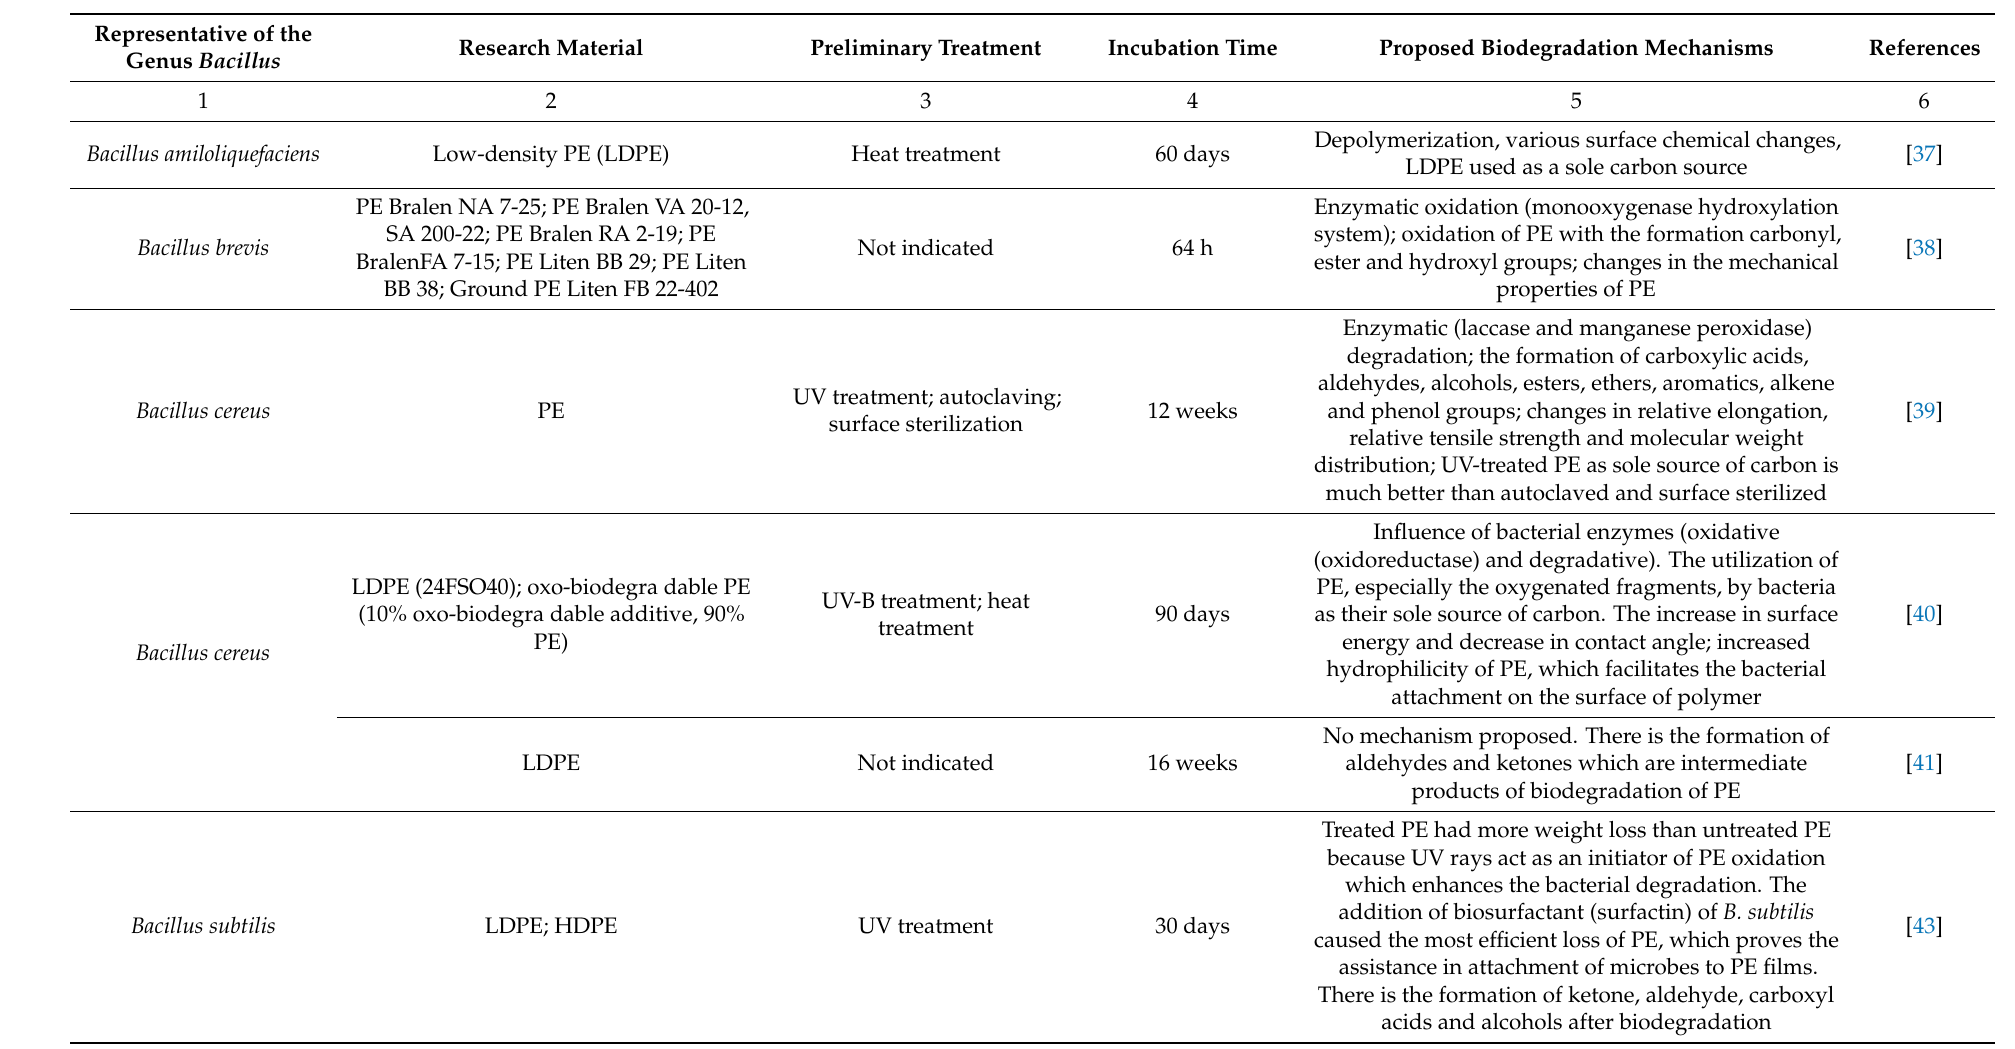
Table 3. A summary of the articles on the biodegradation of PE with the participation of bacteria of the genus Bacillus